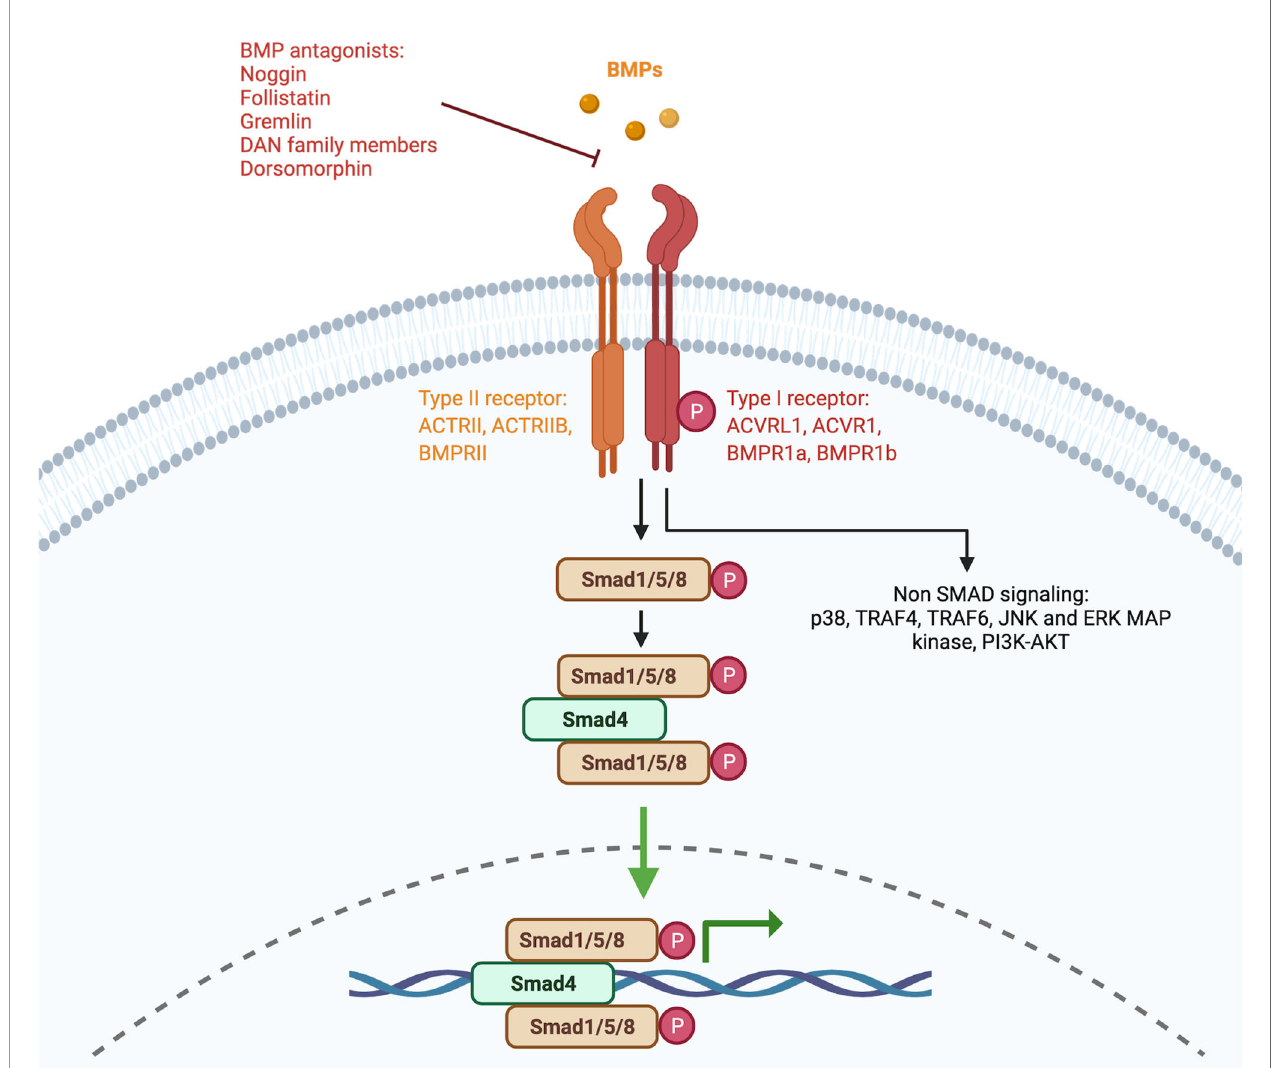
FIGURE 1 | Signaling pathway of BMPs. Simpli fi ed schematic representation of the BMP signaling pathway. Members of the BMP family bind to serine/threonine receptors that are composed of type I and type II receptors which form heteromeric complexes. The signaling pathway can be divided into the canonical pathway and the non-canonical pathway. In the canonical pathway, also known as the SMAD-dependent pathway, SMAD1/5/8 proteins are phosphorylated and form complexes with a common SMAD4. In the non-canonical pathway, BMPs signal without the involvement of SMAD proteins. Created with